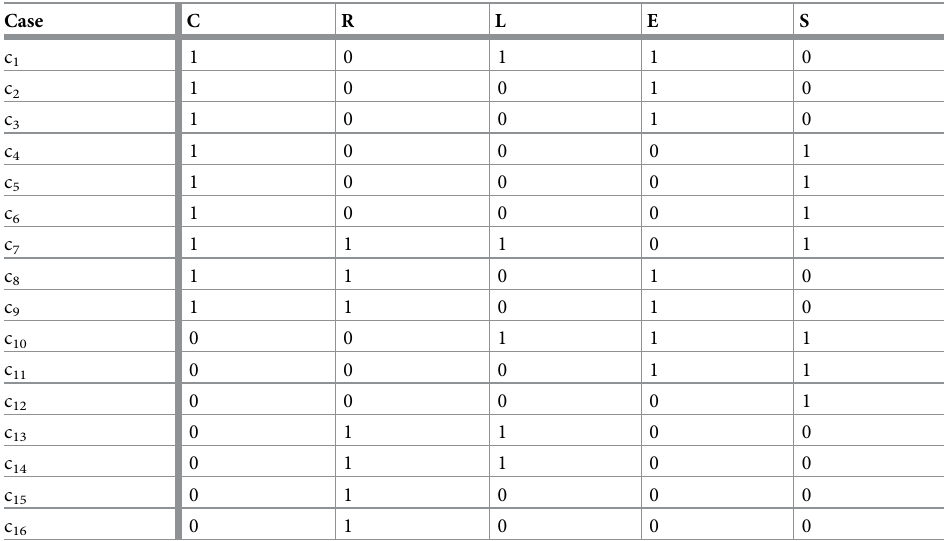
Table 4. Data collected by social scientist John Doe.